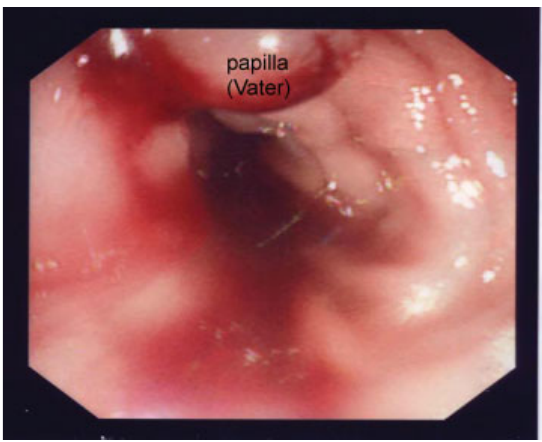
Fig. 1 Hemobilia at endoscopy. Note the blood at ampulla of Vater.